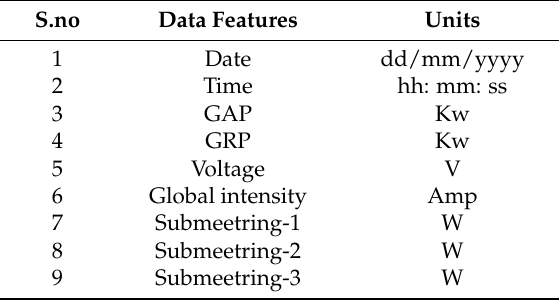
Table 2. Individual household electricity consumption prediction (IHEPC) dataset variables description and